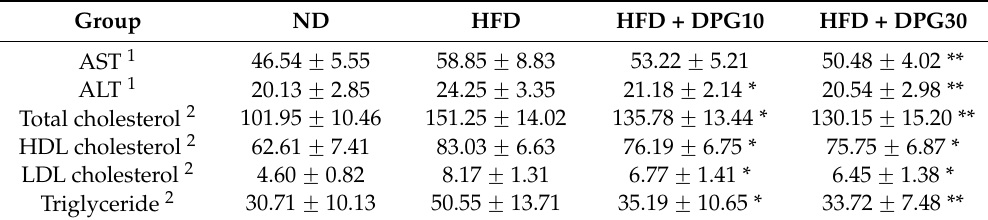
Table 2. Effect of DPG on biochemical parameters of serum in HFD ‐ induced obese mice.